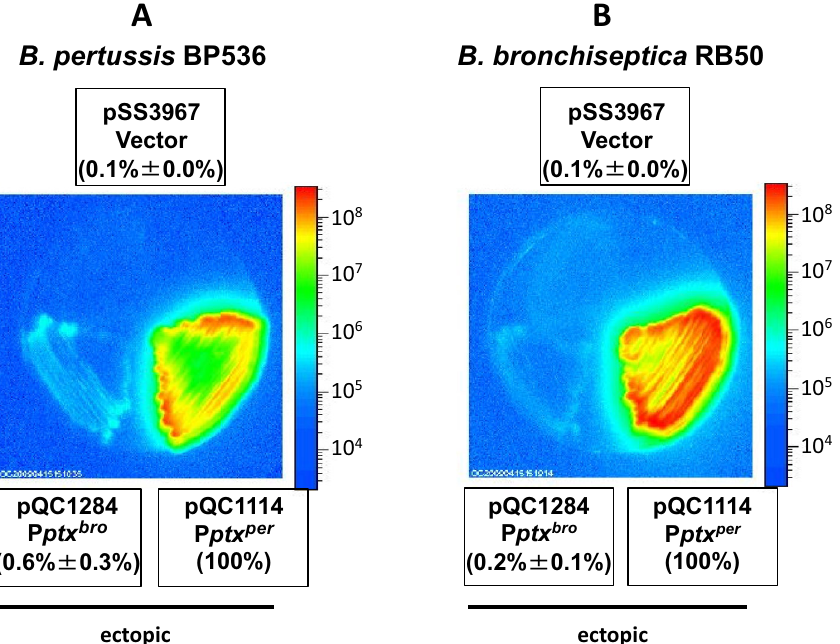
Figure 3. Comparison of the inherent transcriptional activity of P ptx bro and P ptx per A . Plasmids pQC1284 and pQC1114 containing P ptx bro and P ptx per , respectively, as lux fusions in vector pSS3967 were integrated into B. pertussis BP536 ( A ) or B. bronchiseptica RB50 ( B ) to generate ectopic fusions. The resulting B. pertussis BP536 and B. bronchiseptica RB50 strains were grown on BG agar for 2 days or 1 day, respectively, at 37 °C. Light output was observed, analyzed and presented as described for Fig.